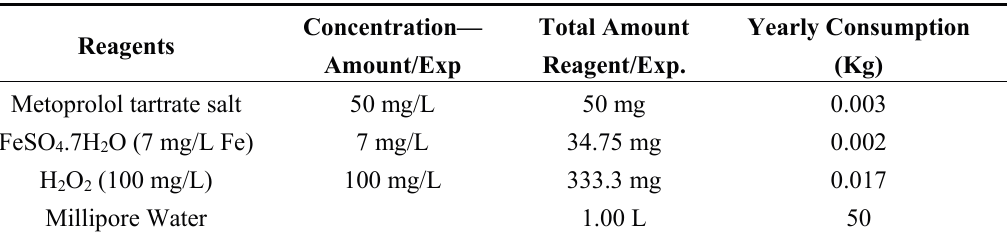
Table 8. Reagent consumption in photo-Fenton experiments with a 1-L reaction volume for 50